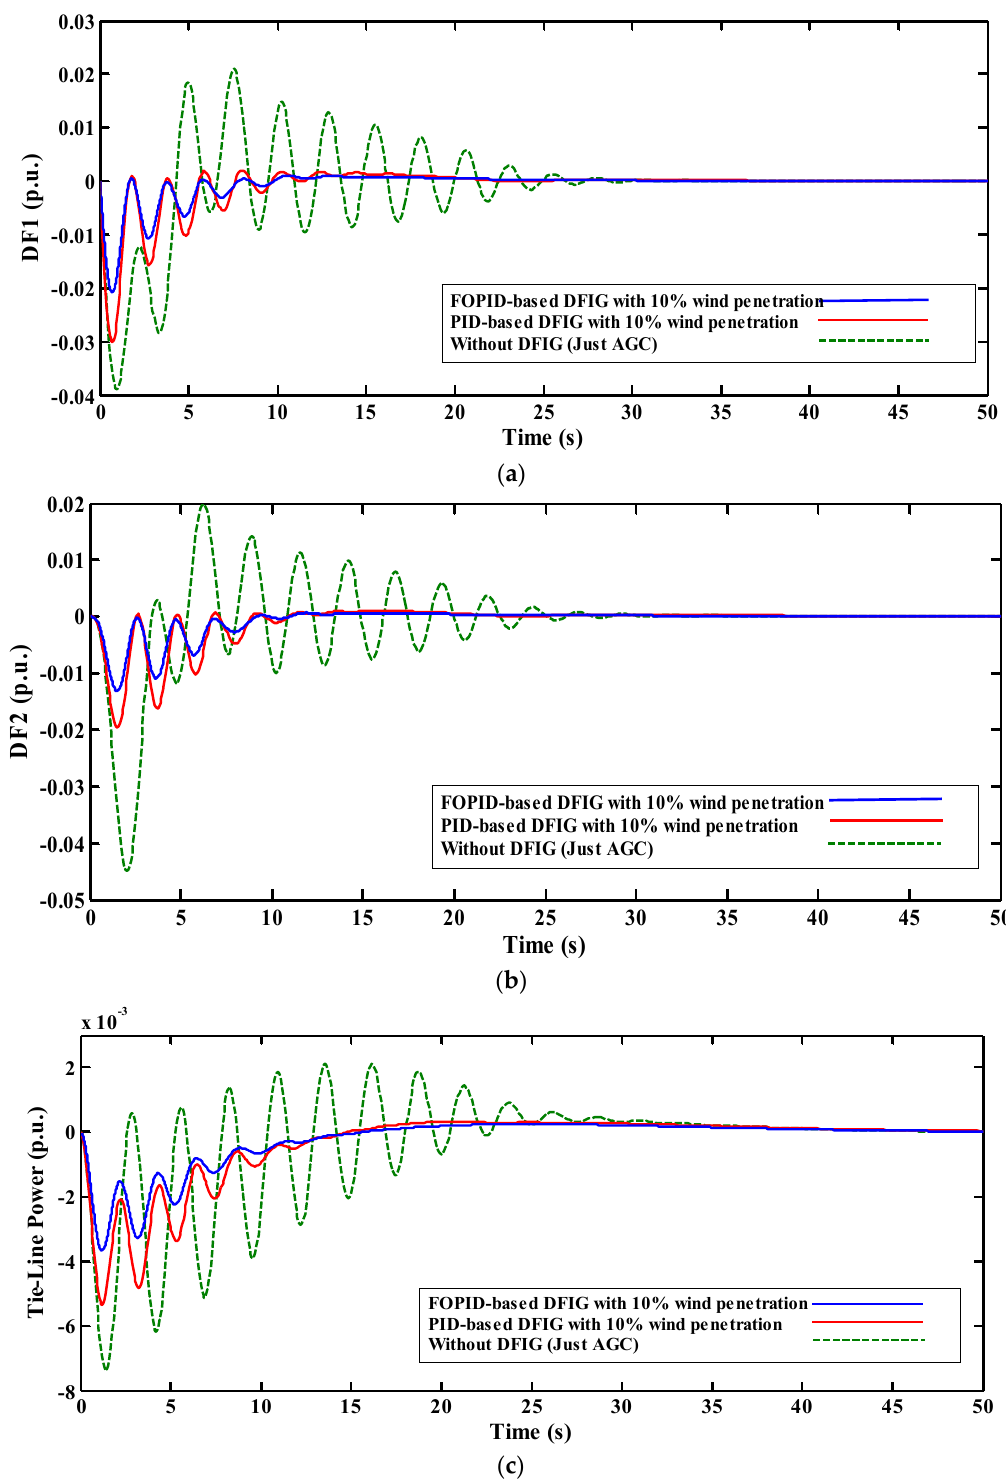
Figure 5. Frequency deviation and tie-line active power change in the first scenario, ( a ) frequency deviation in area 1; ( b ) frequency deviation in area 2; and ( c ) tie-line power deviation. Table 3. Frequency deviation and tie ‐ line power characteristics of FOPID, PID and just AGC.